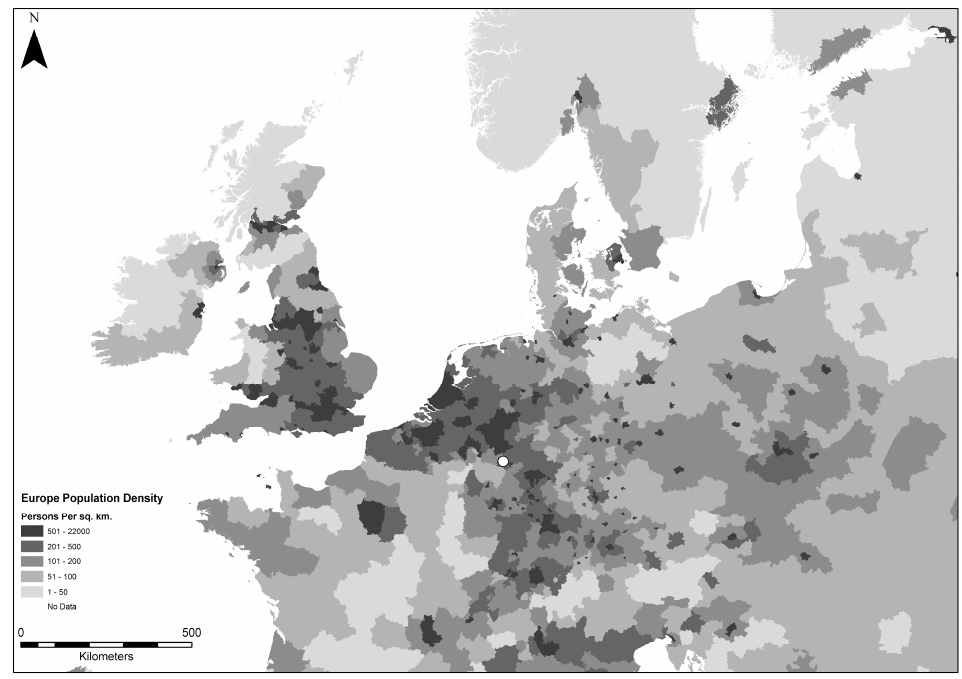
Figure 6. Current population densities in Europe with the Laacher See volcano marked in the region’s center. Compare this to Figure 5 above. Source: ESRI.